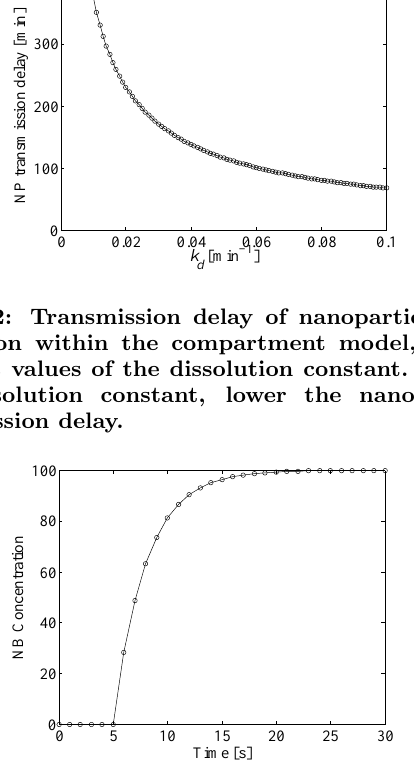
Figure 3: Binding concentration within the com- partment model, which occurs for t > 5 s, and in- creases until reaching the maximum value NB